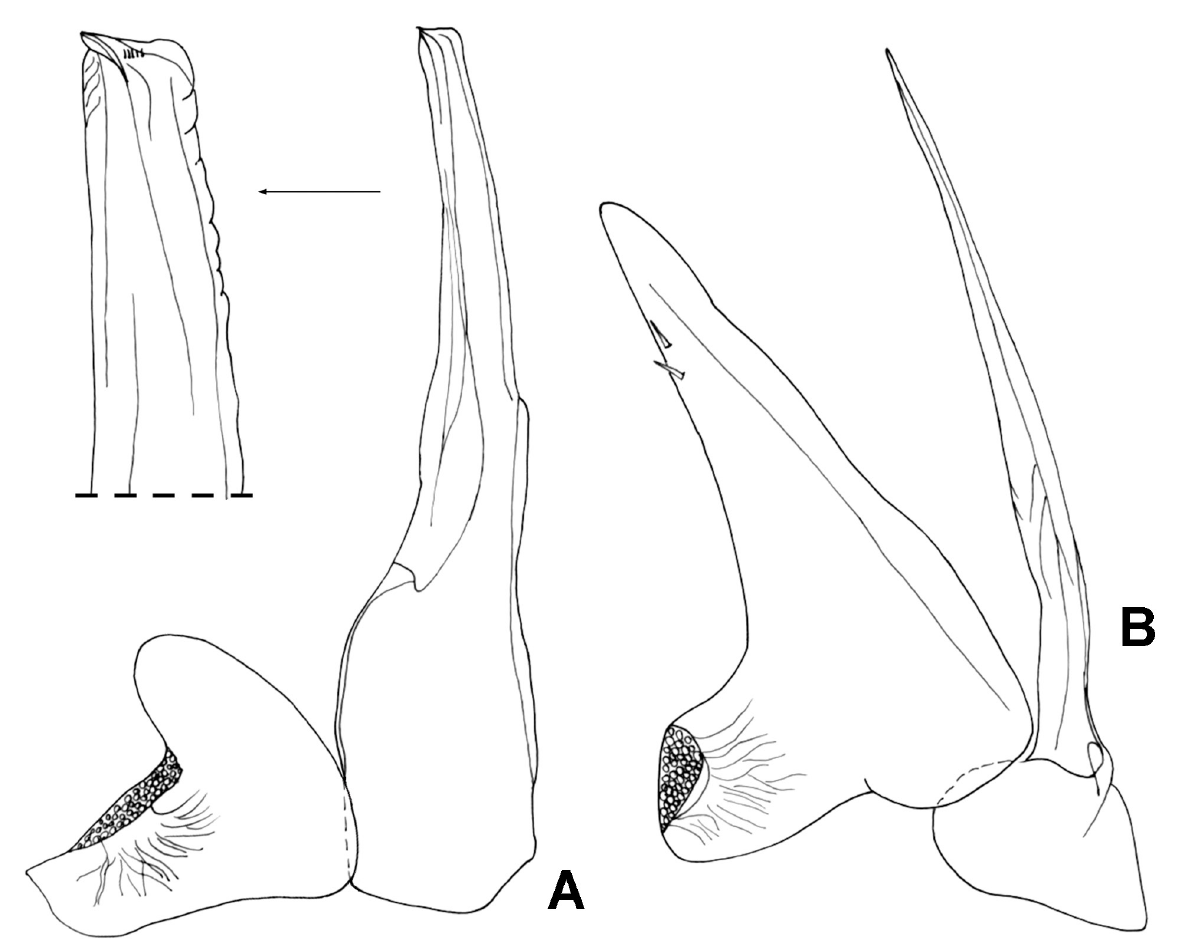
Fig. 31. Eluma tuberculata Cruz, 1991 from Gruta do Soprador do Carvalho, Sicó, ♂. A . Pleopod 1. B . Pleopod